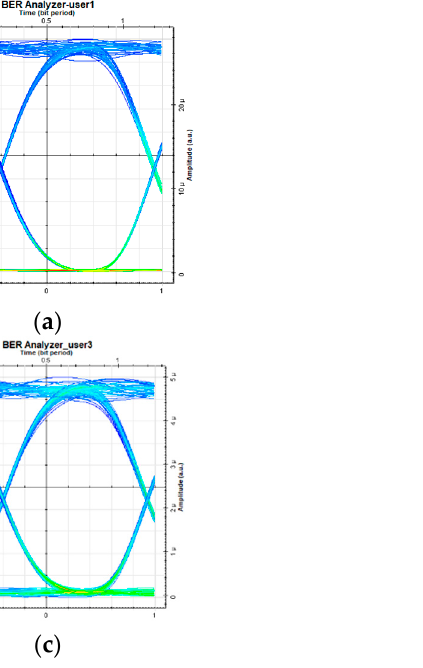
Figure 8. Eye diagrams: ( a ) for the first user; ( b ) for the second user; ( c ) for the third user; ( d ) for the fourth